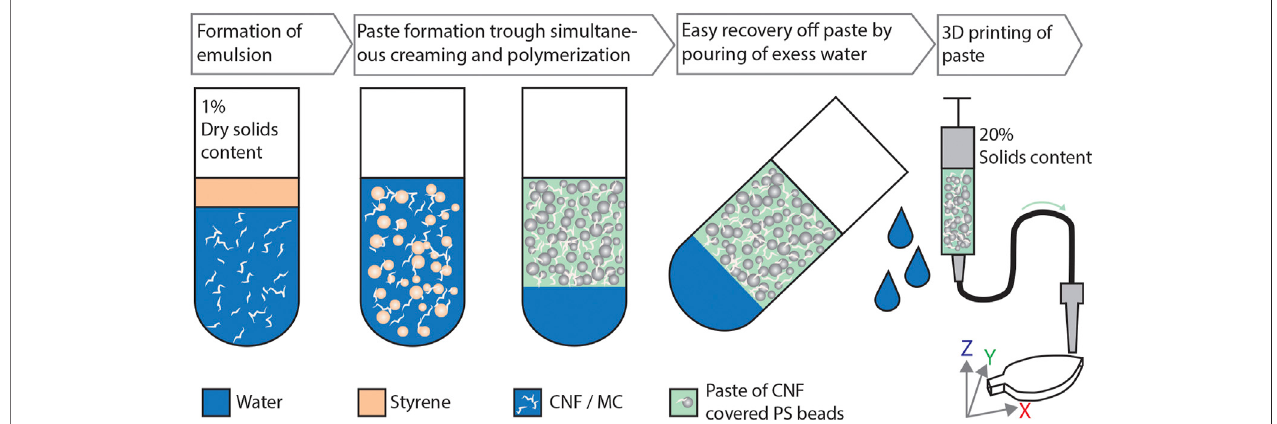
FIGURE 1 | The evolution of mechanically disintegrated CNF, dissolved MC and styrene into a high-solids creaming layer suitable for additive manufacturing prepared via emulsion templating. Simultaneous creaming and polymerization of styrene-in-water emulsion stabilized with CNF and MC forms a paste-like material consisting of polystyrene beads covered with MC and CNF. The distinct two-phase system allows effortless removal of free